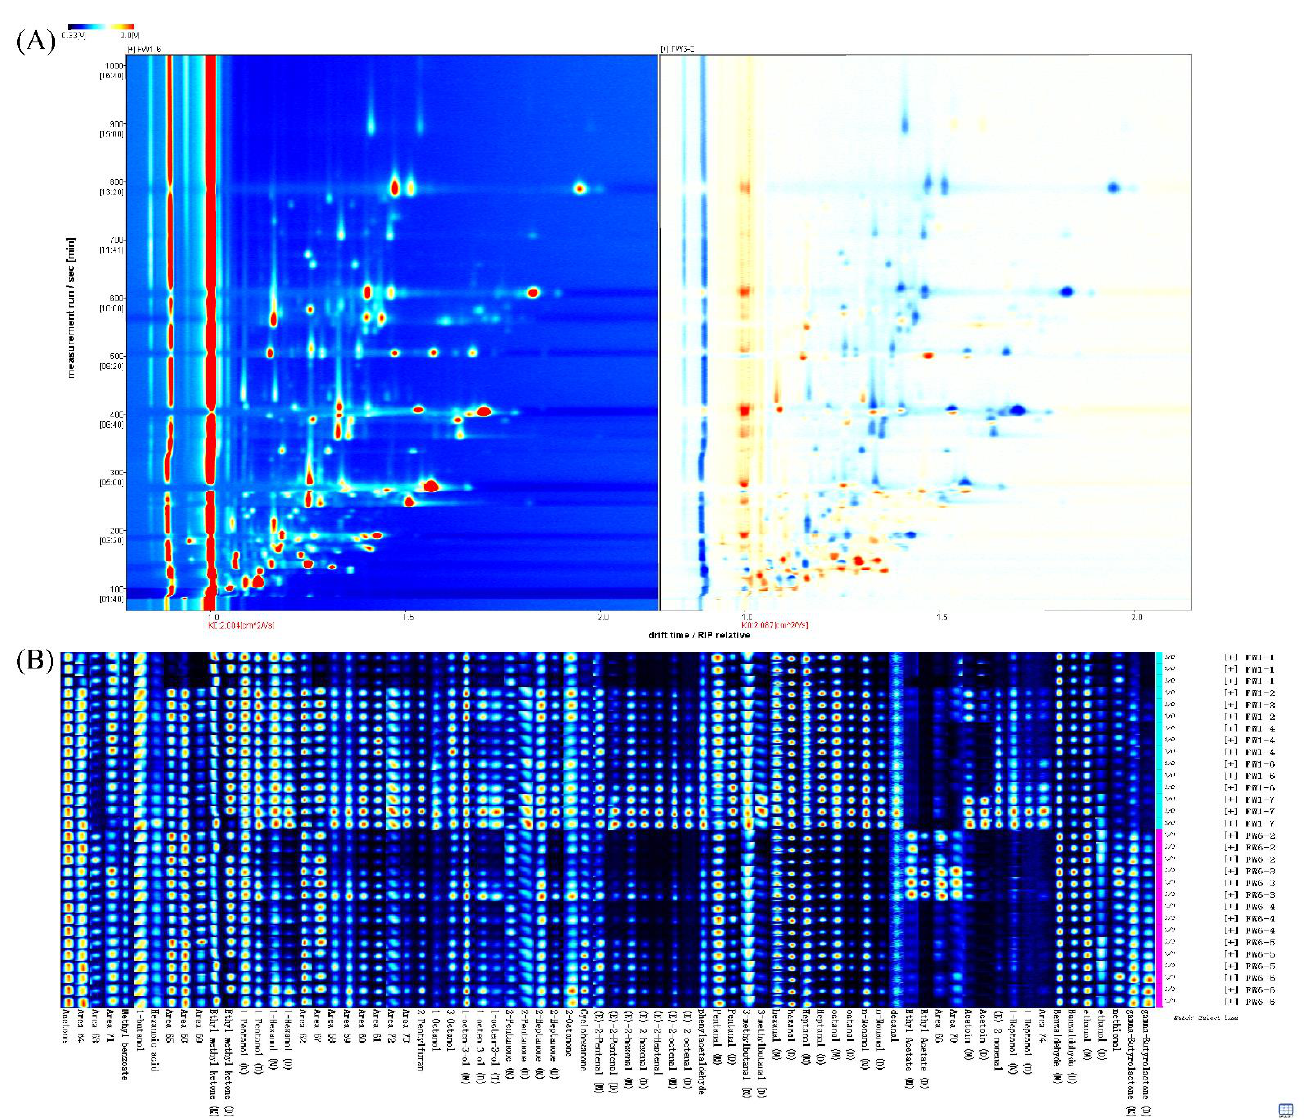
Figure 4. Volatile compound profiles in concentrate-fed (CF) and pasture-fed (PF) groups ( n = 5). ( A ) Two-dimensional topographic plots for lamb with different feeding systems. The darker color indicates greater intensity (red represents to high levels of volatiles and white represents to low levels). ( B ) Gallery plot of the selected signal intensities collected with different feeding systems.